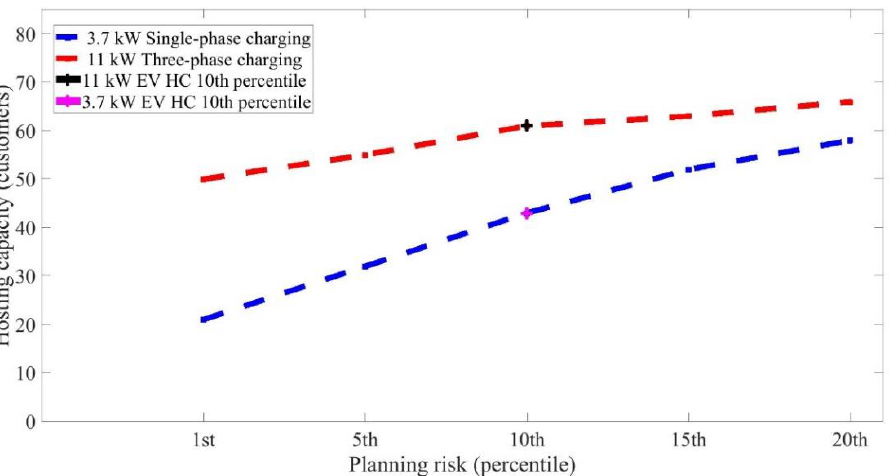
83-customers distribution